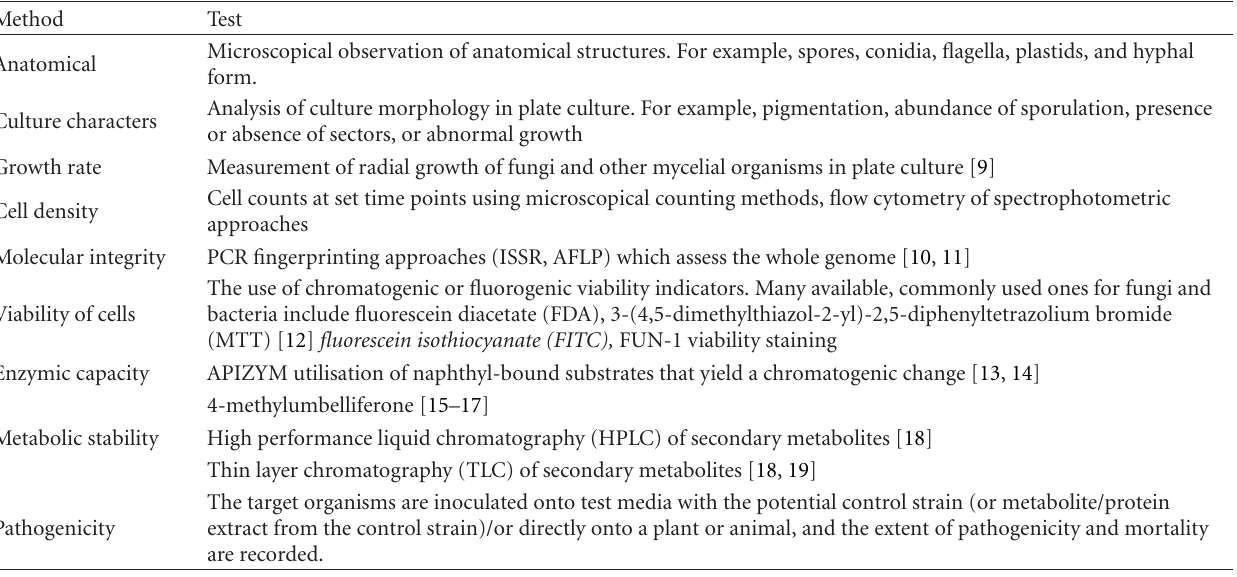
Table 2: Some commonly used methods used to assess strain stability following